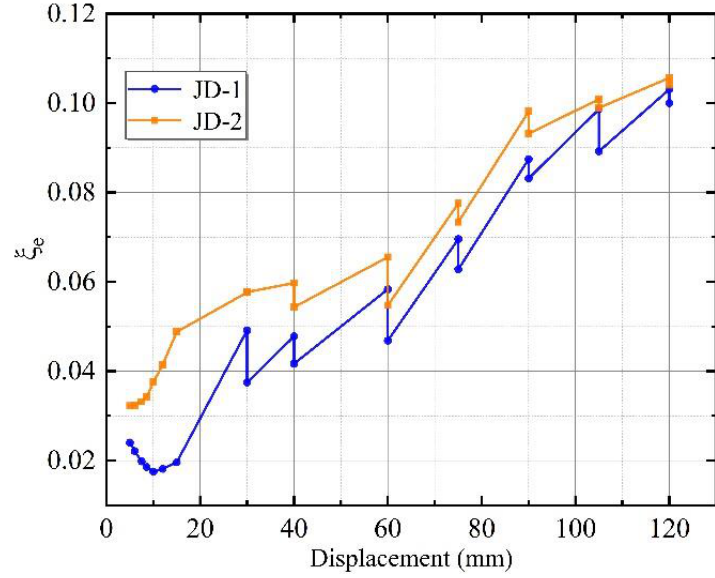
Figure 12. The equivalent viscous damp ratio of JD-1 and